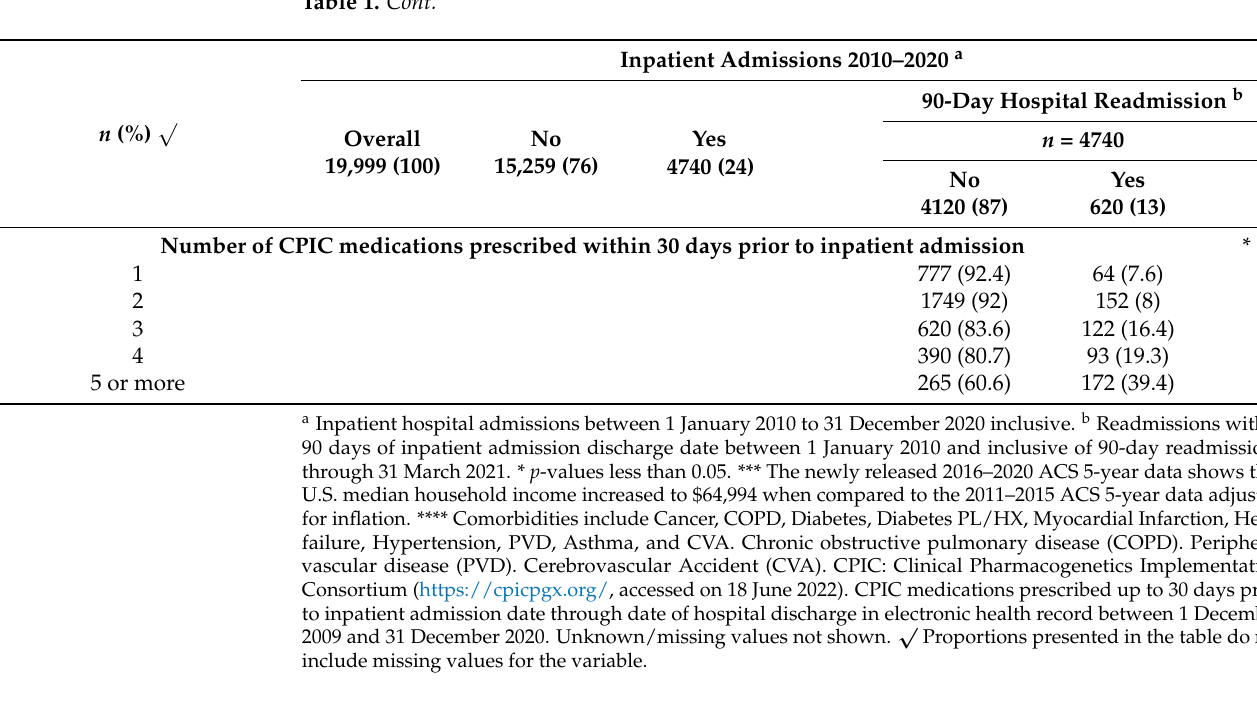
Characteristics of Patient Subpopulations with Inpatient Admissions and 90-day Hospital